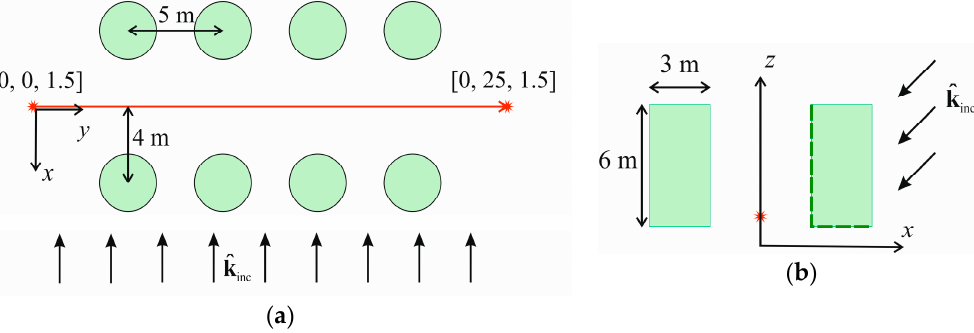
Figure 5. The selected artificial scenario with a terminal moving from [ 0, 0, 1.5 ] to [ 0, 25, 1.5 ] with a step of 0.2 λ : ( a ) top view; ( b ) front view. The alley of trees is selected so that there is one row on the left side and one row on the right side of the terminal, each at a distance of 4 m. The cylindrical tree canopies are separated by 5 m and have radius of 1.5 m and height of 6 m. The incident plane wave illuminates the scenario perpendicularly to the alley under the elevation angle of 45 ◦ . The dark green dashed line in ( b ) indicates the inner part of the canopy illuminated by the incident plane wave as utilized by the combined PO/MST model.